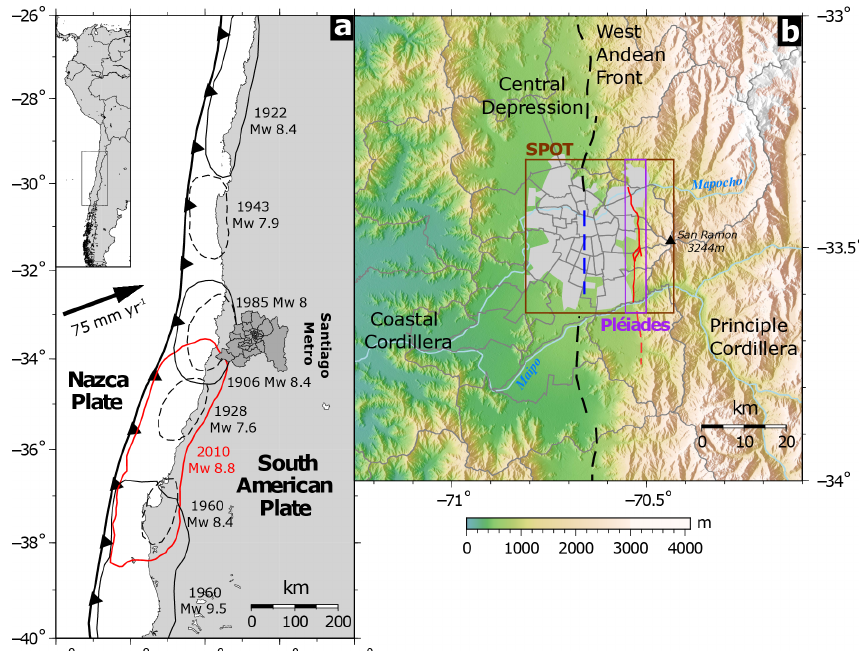
Figure 2. (a) Map of central Chile showing the location of great earthquakes for the past century in the subduction zone where the Nazca plate is converging beneath the South American plate at a rate of 43mmyr − 1 (Zheng et al., 2014). The Santiago metropolitan region is shown in the dark grey outline, subdivided by commune (names of all the communes are given in Fig. S1). (b) A 90m SRTM shaded terrain map of the region around Santiago city (light grey). The SPOT and Pléiades satellite data used in this study cover the region shown by the maroon and purple polygons respectively. The San Ramón Fault is shown in red, while the dotted blue line is the location of our inferred buried fault within the city (see text for details). The dashed black lines are the mountain front faults mapped by Armijo et al.